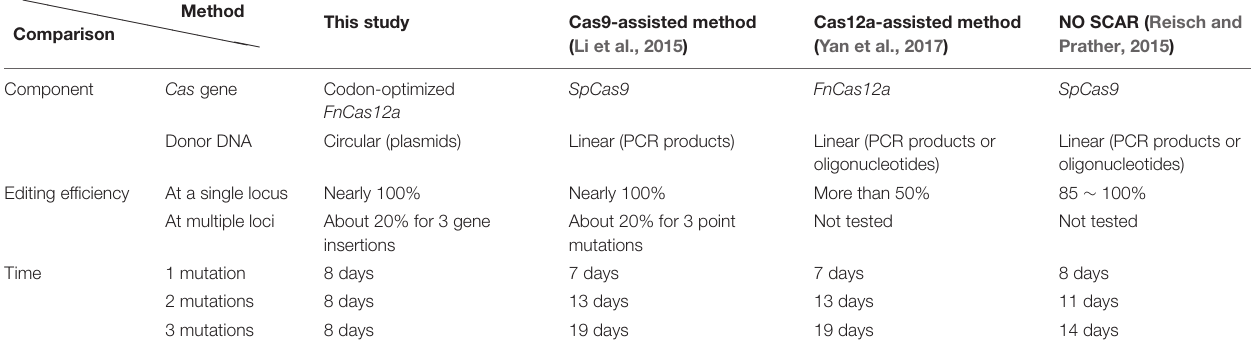
TABLE 2 | Comparisons of genome editing methods assisted by CRISPR-Cas